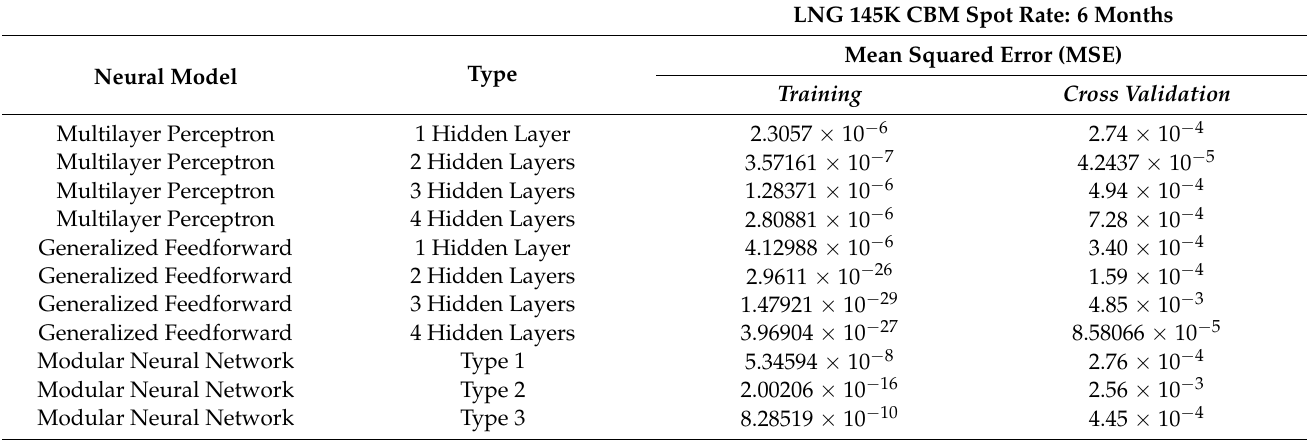
Table 9. Results of forecast for LNG 145K CBM spot rate: 6 months. The best score is shown in bold. LNG 145K CBM Spot Rate: 6